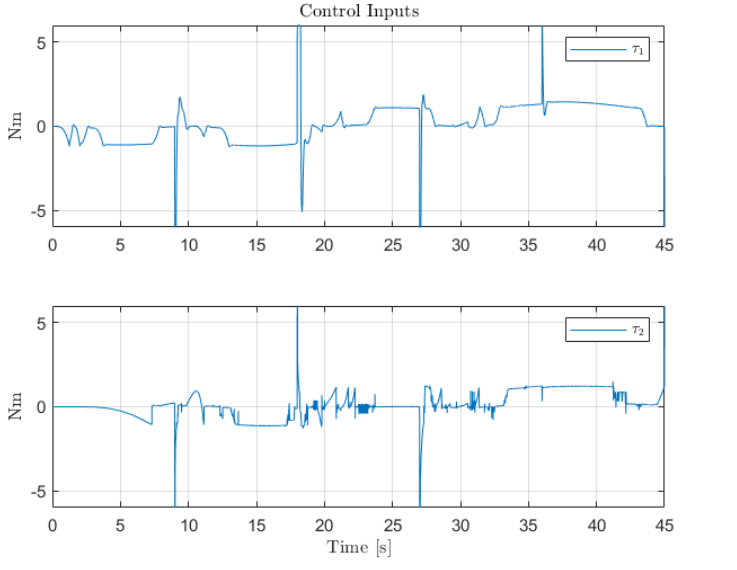
Figure 16. Control inputs for the servo-actuators of Links 1 and 2.